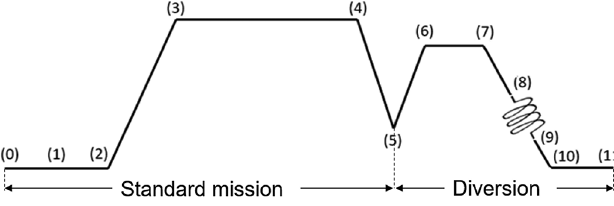
Fig. 7. Typical mission for a transportation aircraft category. Table 1. General assumptions for each fl ight phase of